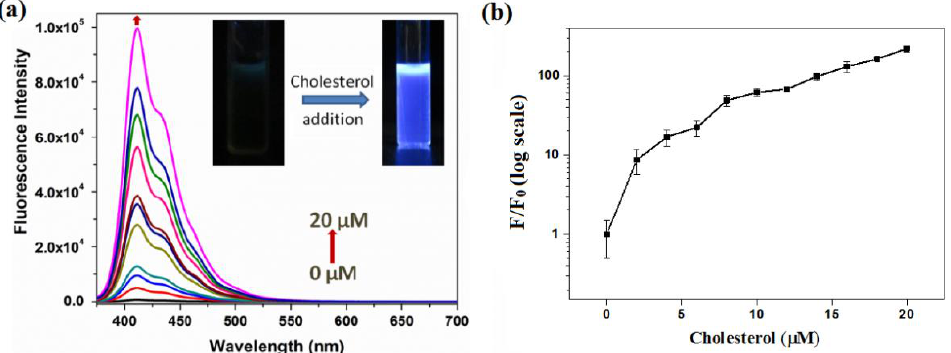
Figure 4. “Turn - On” fluorescence response of pre -quenched OFP-CD solutions upon the addition of cholesterol in water; ( a ) Evolution of the fluorescence emission spectra of OFP-CD+Q ([OFP-CD] = 1 µM, [dabsyl chloride] = 10 µM) upon addition of various concentrations of cholesterol (0 – 20 µM) in water. Inset: photographs showing change in fluorescence under a hand-held UV lamp before and after addition of cholesterol; ( b ) Ratio of fluorescence intensity of polymer observed (F) to that of the initial emission intensity (F 0 ) as a function of cholesterol concentration.